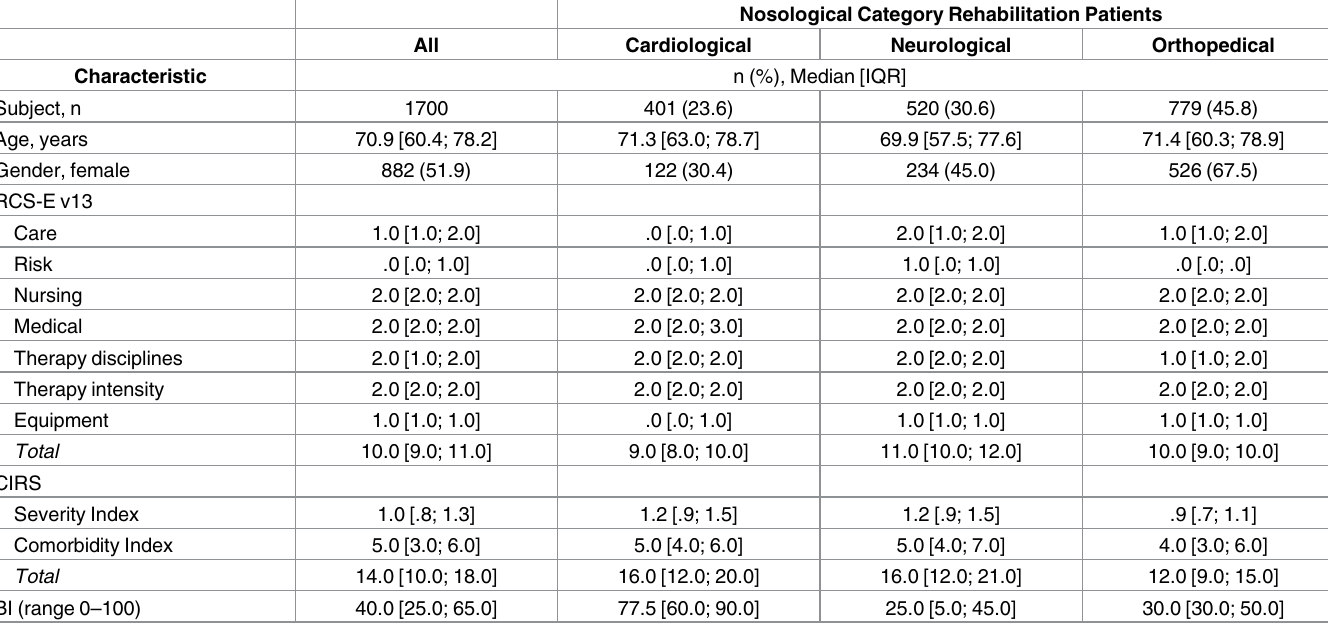
Table 2. Demographic and clinical characteristic of patients statistically analysed (N =